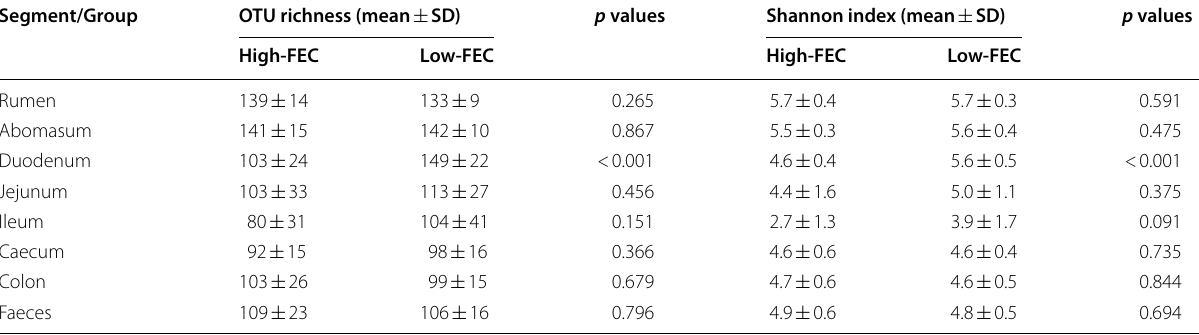
The ANOVA with Tukey’s post-hoc test was used to assess the differences among groups FEC, faecal egg count; SD, standard deviation